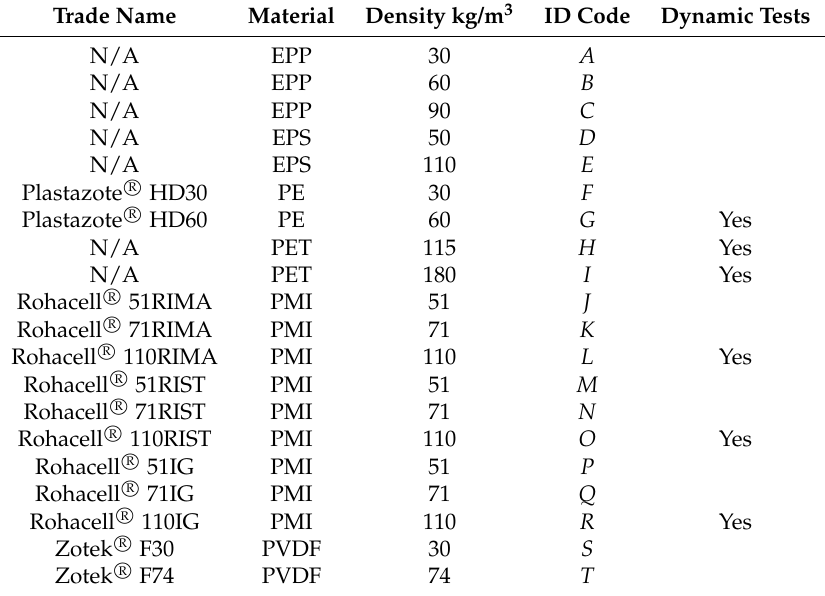
Table 1. Physical properties of the investigated materials: foams.